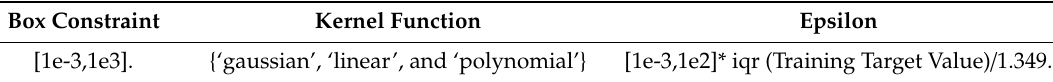
Table A4. Matlab toolbox SVR optimization parameter settings.